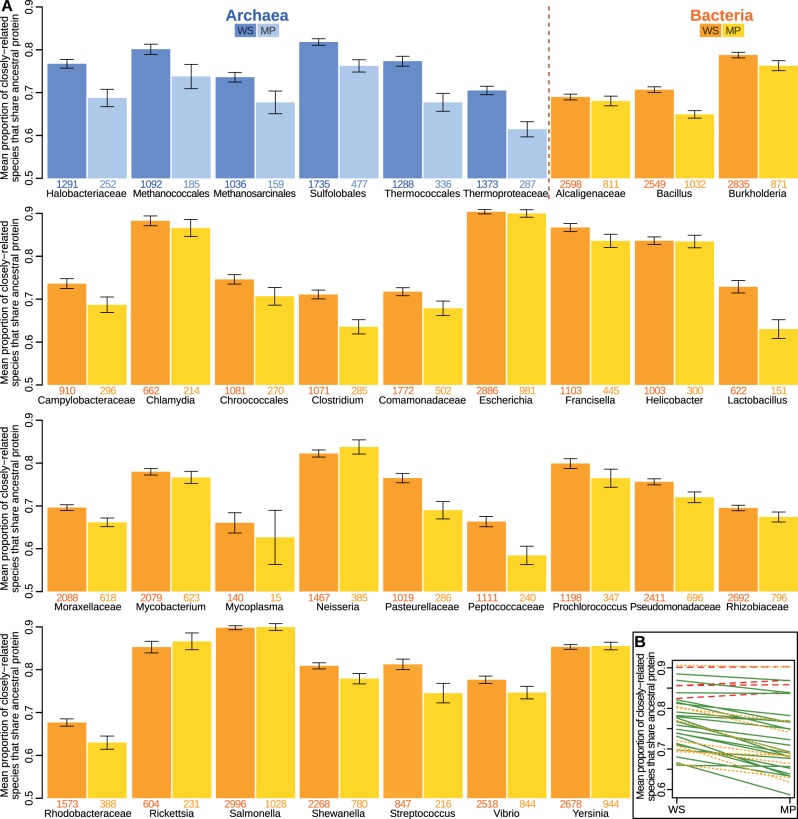
Ancestral membrane proteins have been lost more frequently. (A) Predicted ancestral proteins (defined as shared by at least half of the members of a clade), are shared by a smaller proportion of members in the clade if they are membrane proteins, for 31 of the 35 groups studied (exceptions are Neisseria, Rickettsia, Salmonella, and Yersinia). Dark shade: water-soluble; light shade: membrane proteins. First six pairs (blue) are archaeal clades, the remainder (yellow) are bacterial. Error bars: 2×SEM. Digits below bars indicate the numbers of orthologous groups. (B) Values as in (A), paired and without error bars. Red-dashed: results with higher mean proportion of sharing species for MP than WS. Yellow-dotted: results with MP<WS but P-value over a cutoff of 0.05 in a two-sample Welch t-test. Green-solid: results with P<0.05.